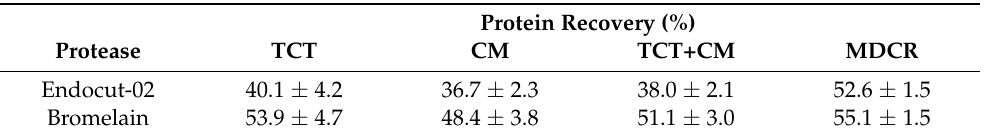
Table 3. The protein recovery from raw materials after 1 h of hydrolysis at the lab scale at 40 ◦ C, at ambient pH, with the selected proteases on four different raw materials (errors given in SD of replicate hydrolysates).